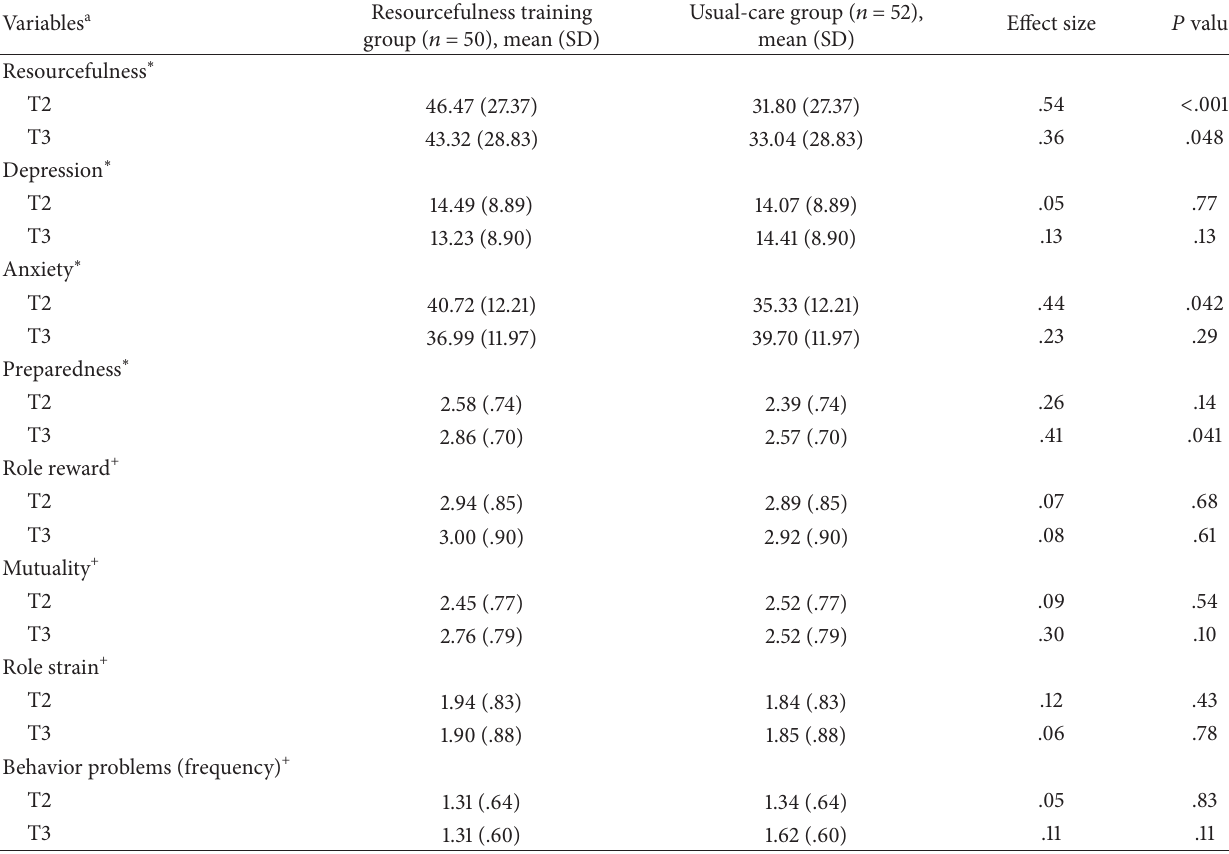
Table 4: Adjusted means, standard deviations, and effect sizes for study variables over